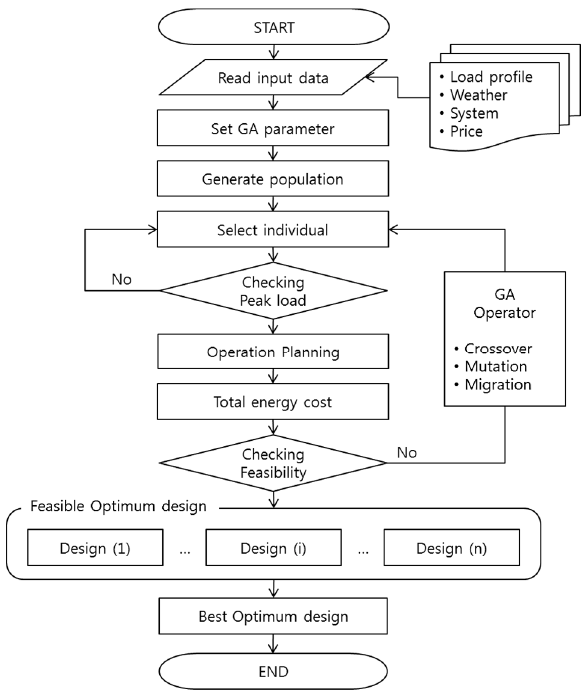
Figure 3. Genetic algorithm flowchart.